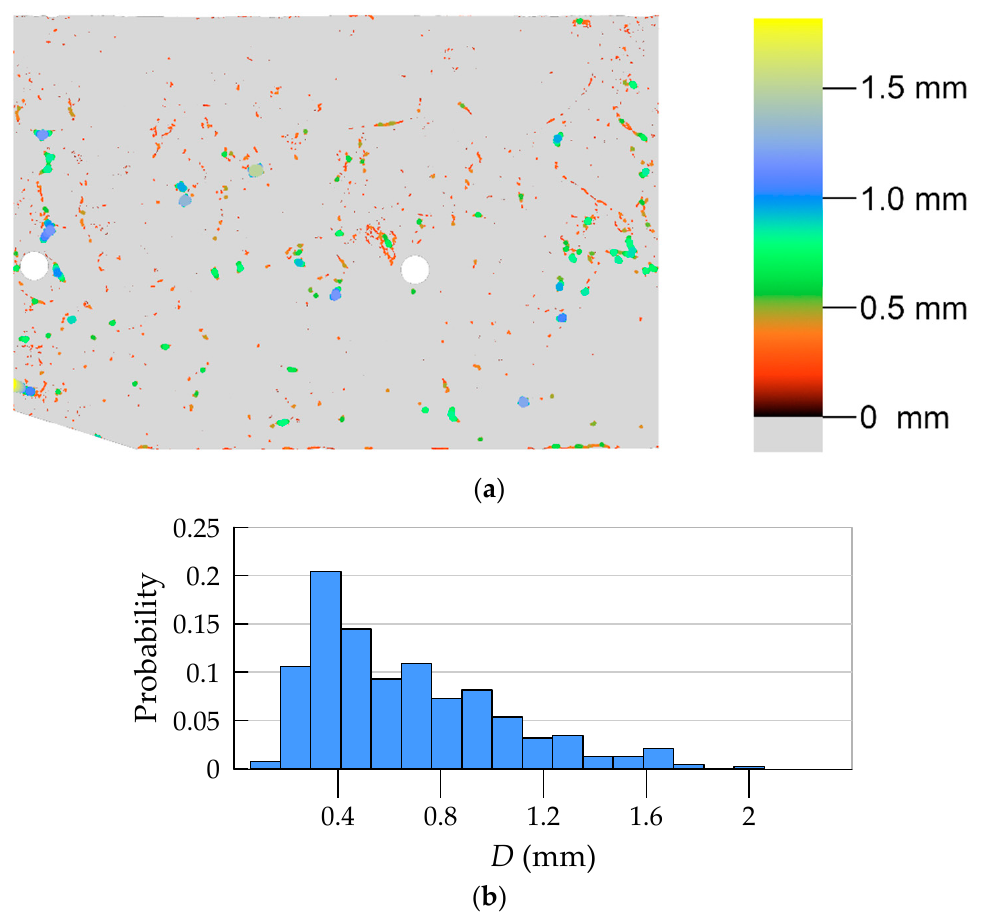
Figure 11. Pore local thickness: ( a ) contour map; ( b ) histogram.